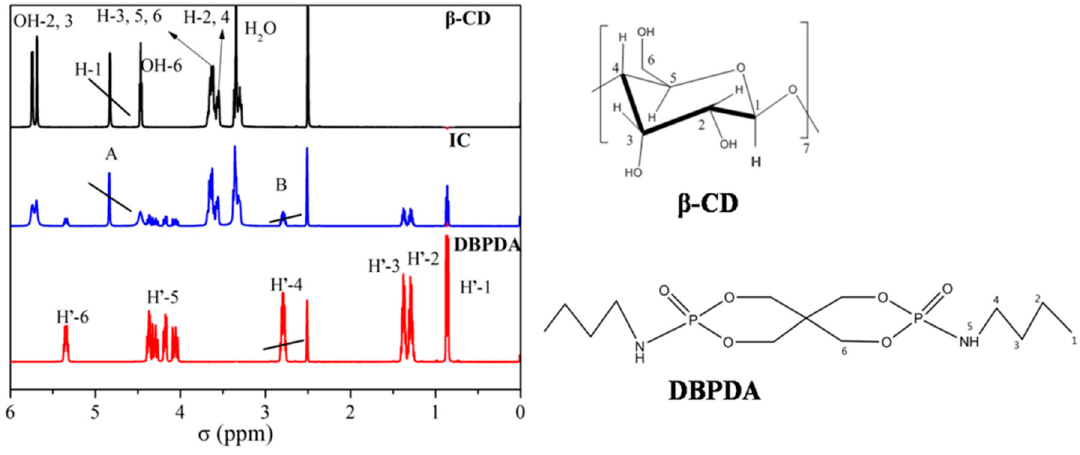
Figure 2. 1 H NMR spectra of β -CD, IC and DBPDA.